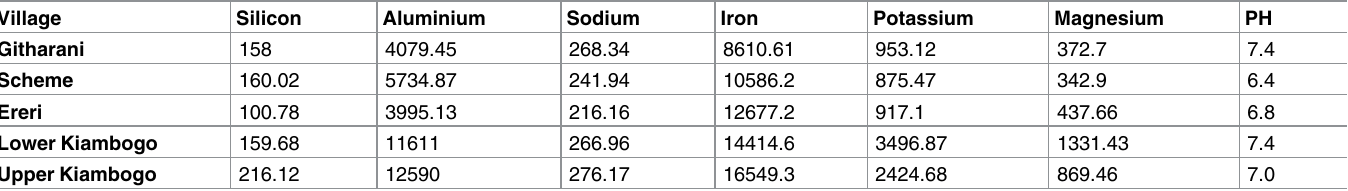
Table 4. Distribution and concentration of soil elements in mg/kg and soil PH in soil sampled in Mt Longonot area by village. Village